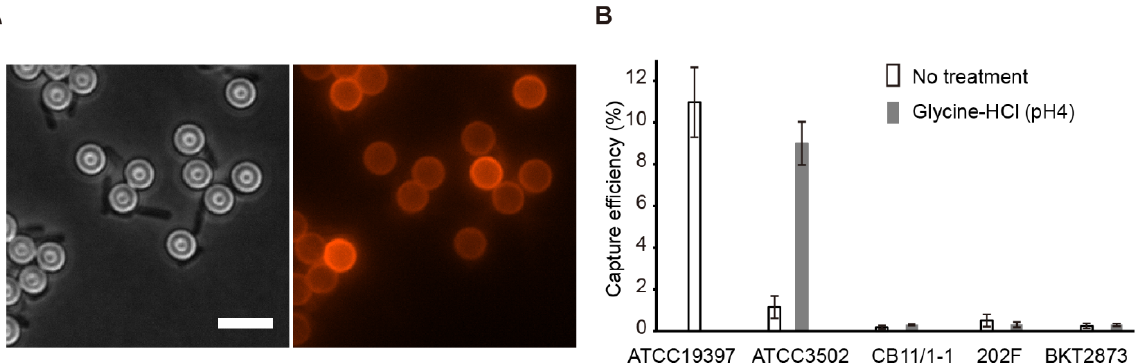
Figure 4. mCherry-CBD-based magnetic separation of Clostridium botulinum ATCC3502 and ATCC19397 from C. botulinum CB11/1-1, 202F, and BKT2873 strains. ( A ) Representative microscopic images of the binding of C. botulinum ATCC19397 cells to mCherry-CBD-coated M-280 beads. Bar, 5 µm. ( B ) Evaluation of the performance of mCherry-CBD-based magnetic separation. The capture efficiency was obtained by calculating the ratio of cell counts before and after magnetic separation. The results are presented as the means of three replicates ± standard deviations.